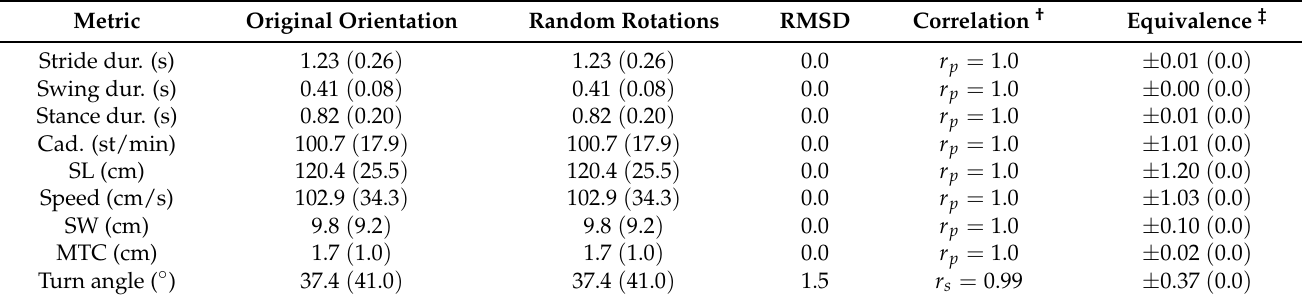
The comparison of gait parameters extracted using the original sensor orientation and using simulated rotations is shown in Table 6. As can be observed, all parameters, except turning angle, present the same values when the sensor is rotated, i.e., all parameters have a RMSD of 0.0, except turning angle that has a RMSD of 1.5 ◦ . The correlation between turning angles extracted using the original orientation and random rotations of the sensor is very high ( r s = 0.99). The performance of the system when data are synthetically rotated remains practically equivalent (equivalence tests have p < 0.01 for all gait metrics, considering an equivalence interval of 1% of the average of the metric). Table 6. Orientation invariance results ( n = 7138 strides). Shown are mean values (standard deviation), RMSD, Correlation— with Spearman or Pearson—and equivalence interval ( p -value). † All correlations have p < 0.01. ‡ All equivalence tests are based on Paired T -test, except for turning angle, which is based on Wilcoxon signed-rank test. Metric